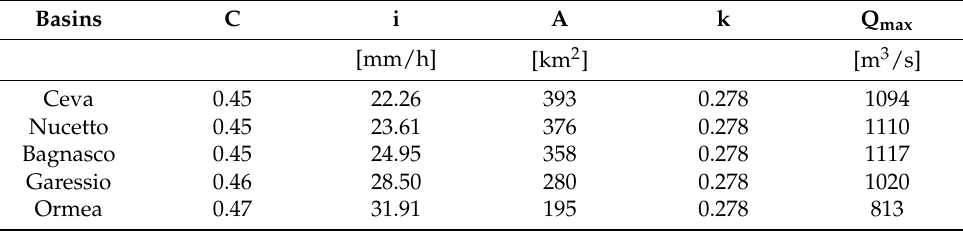
Table 4. Parameters required by Equation (1) and the maximum expected water flow rate (Q max ) for a 200-year recurrence period at each CS along the Tanaro